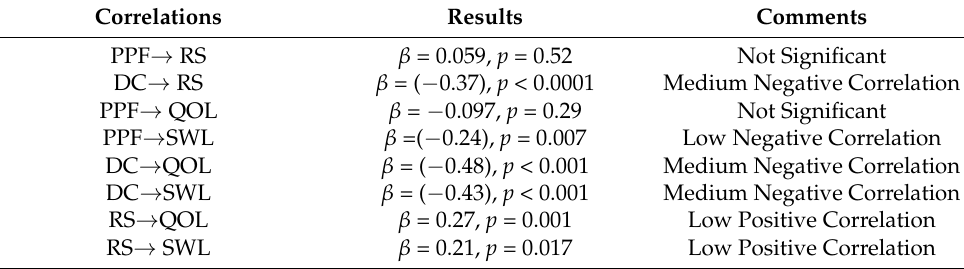
Table 3. Correlations Between the Variables.